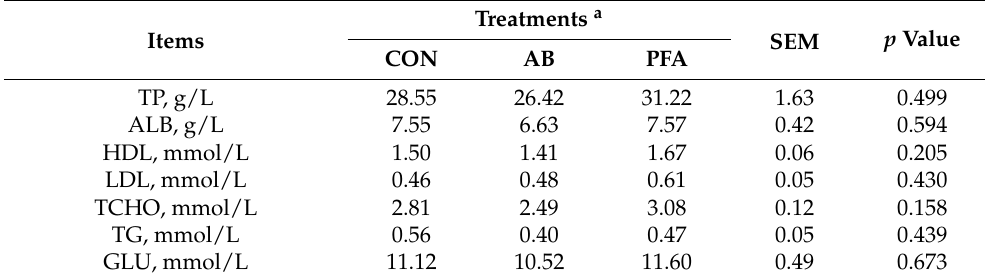
Table 5. Effects of paraformic acid (PFA) supplementation on serum biochemical indicators in broiler